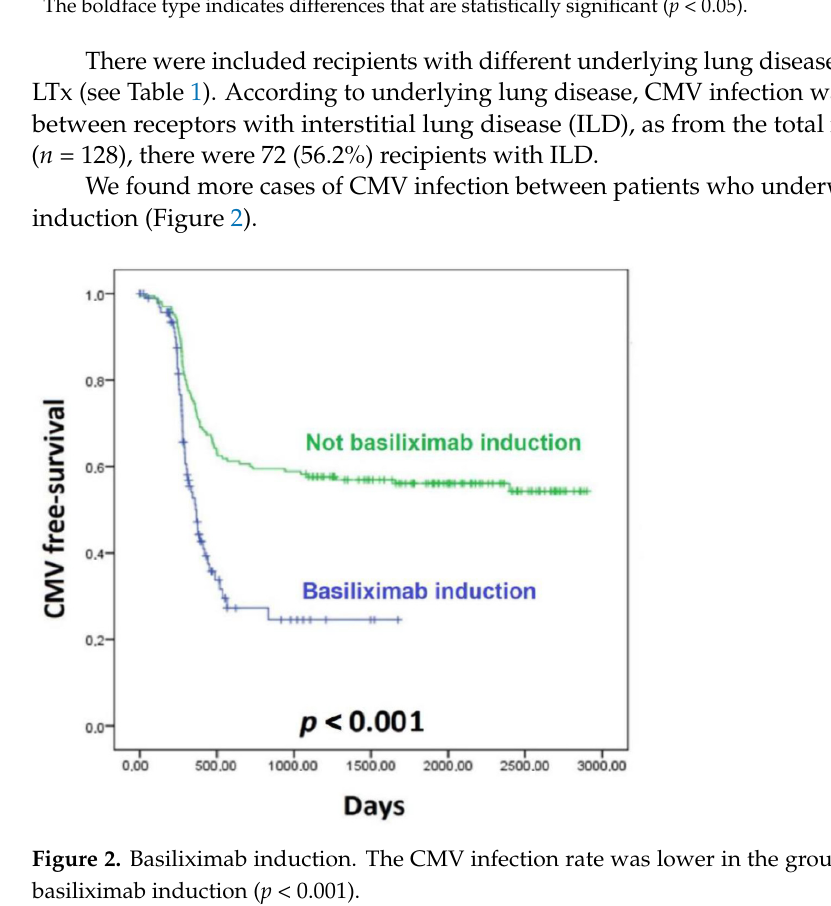
Table 4. Lymphocyte count and detection of the first positive CMV viral